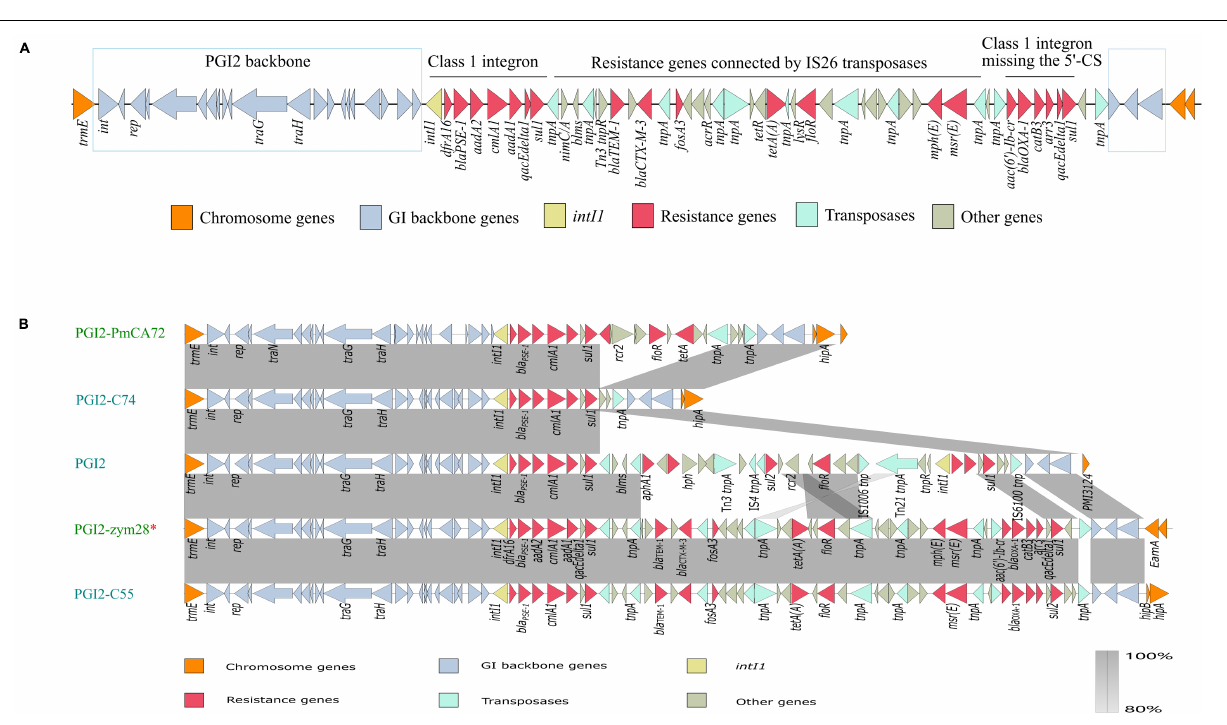
FIGURE 2 | (A) Genetic structure of PGI2-zym28. The different regions corresponding to class 1 integrons and other regions are indicated on the horizontal line. (B) Genetic context comparisons of GIs in PGI2 family. Accession numbers of these GIs are MH990678.1, MK847916.1, MG201402.1, MW080367.1, and MK847915.1 from top to bottom. All the GIs are from Proteus mirabilis except PGI2-zym28. GIs identified from animal hosts are shown in blue and from Homo sapiens are shown in green. PGI2-zym28 in this study is labeled with a red *. Genes and ORFs are shown as arrows, which indicate their orientations of transcription. Shared regions with 80–100% identity are indicated by gradual shading. The picture was drawn with Easyfig